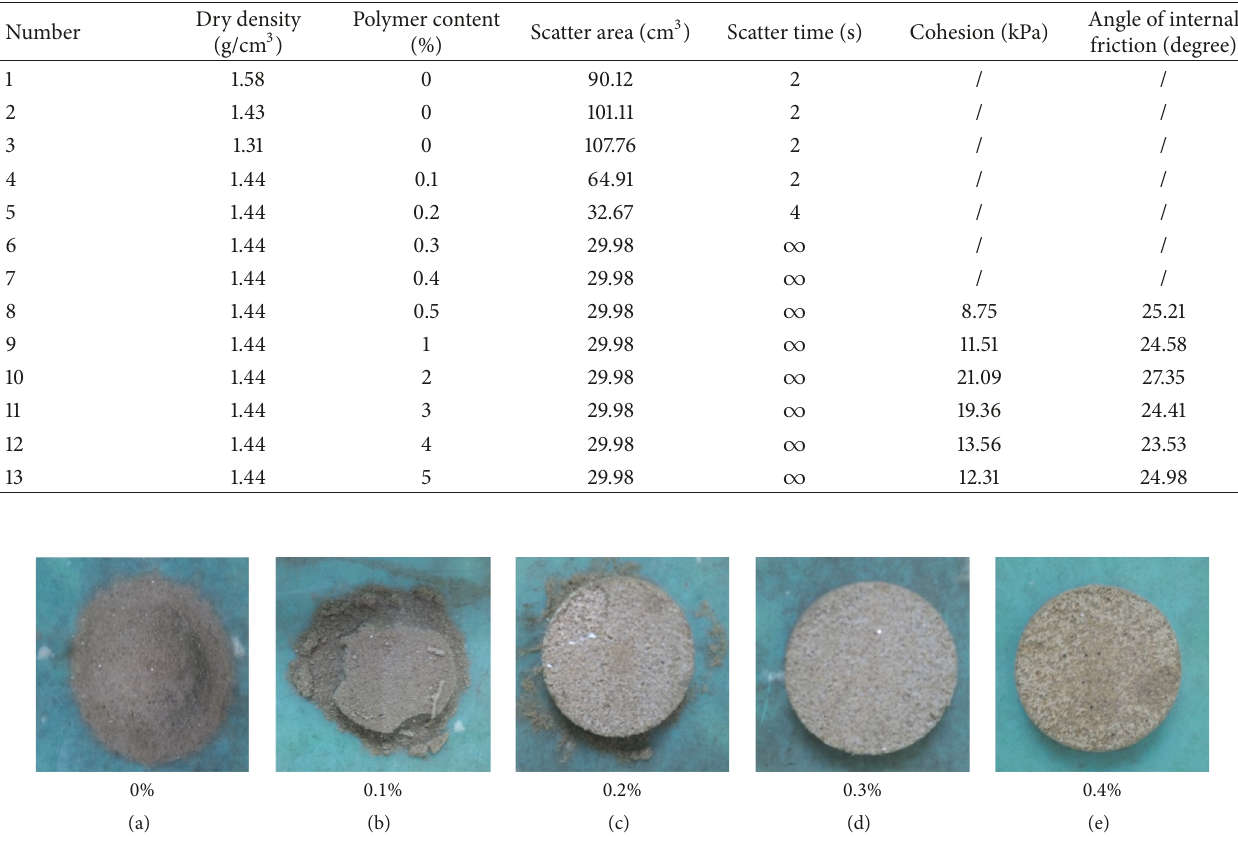
Table 1: The results of reinforced specimens in water stability test.